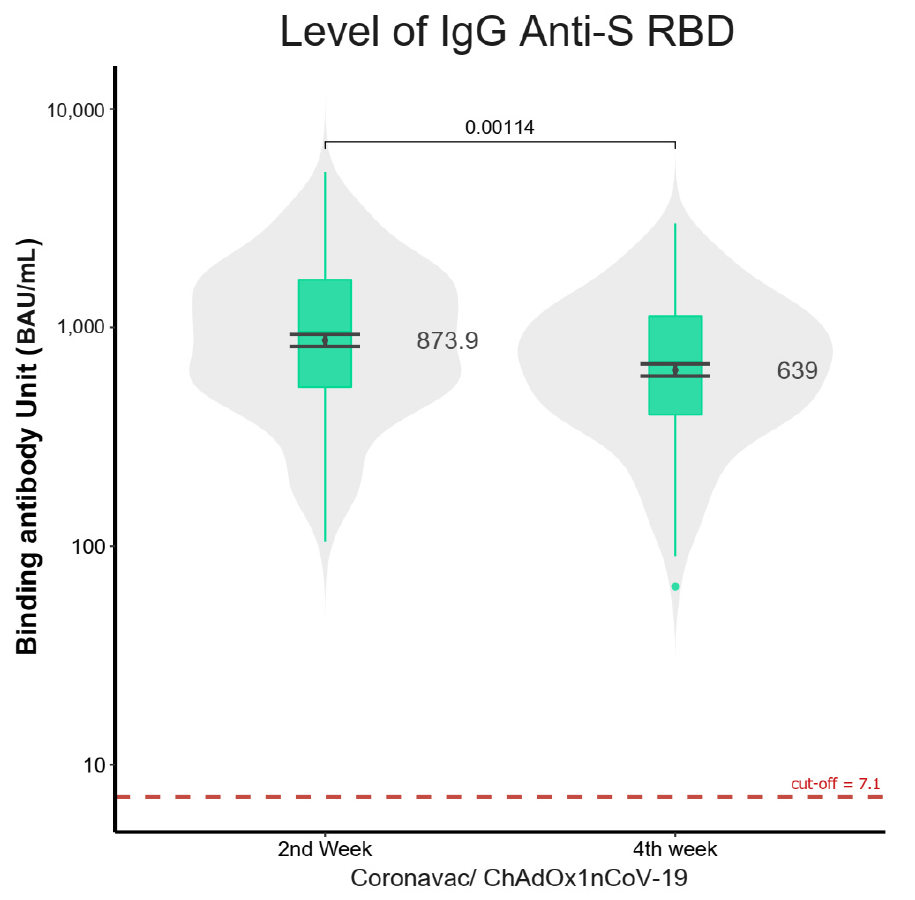
Figure 2. Violin plots comparing level of IgG anti-SRBD titer in CoronaVac-ChAdOx1 group at 2 and 4 weeks. Boxplots show geometric mean and IQRs. Level of IgG anti-SRBD titer at 2 weeks was significantly ( p = 0.00114) (873.9 BAU/mL, 95% CI 768–994) higher than at 4 weeks (639 BAU/mL, 95% CI 563–726). Analysis was performed using the non-parametric Mann–Whitney U test. At 4 weeks, 137 of the 155 participants remained in the CoronaVac-ChAdOx1 group, with 18 participants excluded. From these participants, one was infected with HIV with a low CD4 count, two were infected with COVID-19 after the visit at 2 weeks, and 15 were lost to follow-up; the GMT of anti-SRBD levels was 639 BAU/mL (95% CI 563–726). The GMTs of anti-SRBD levels in the CS group, the homologous ChAdOx1 group, and the homologous CoronaVac group was 227.9 (95% CI 172–303), 211.1 (95% CI 161–277), and 108.2 BAU/mL (95% CI 77–152), respectively. The GMTs of anti-SRBD levels of the CoronaVac-ChAdOx1 group at 2 weeks was significantly higher than that at 4 weeks ( p = 0.00114) (Figure 2). The GMT of anti-SRBD levels of the CoronaVac-ChAdOx1 group at 4 weeks was significantly higher than those of the homologous CoronaVac group, homologous ChAdOx1 group, and CS group ( p < 0.001) (Figure